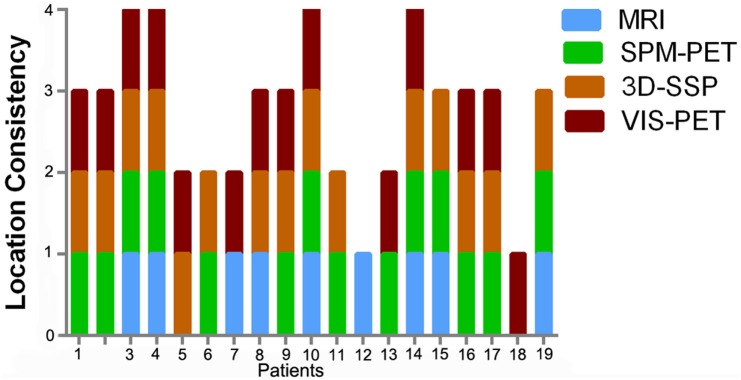
Diagnostic accuracy of each imaging modality among the 19 surgical patients. The columns represent the number of modalities consistent with PEZ for each case.